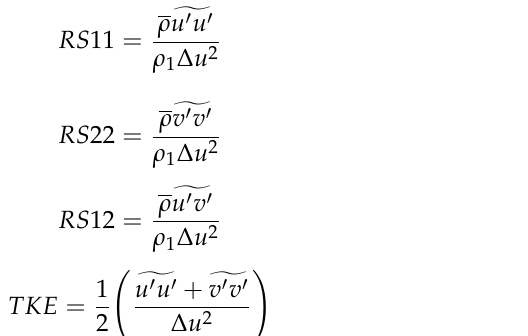
Figure 9. Integration of turbulence intensity along the streamwise direction for three cases.